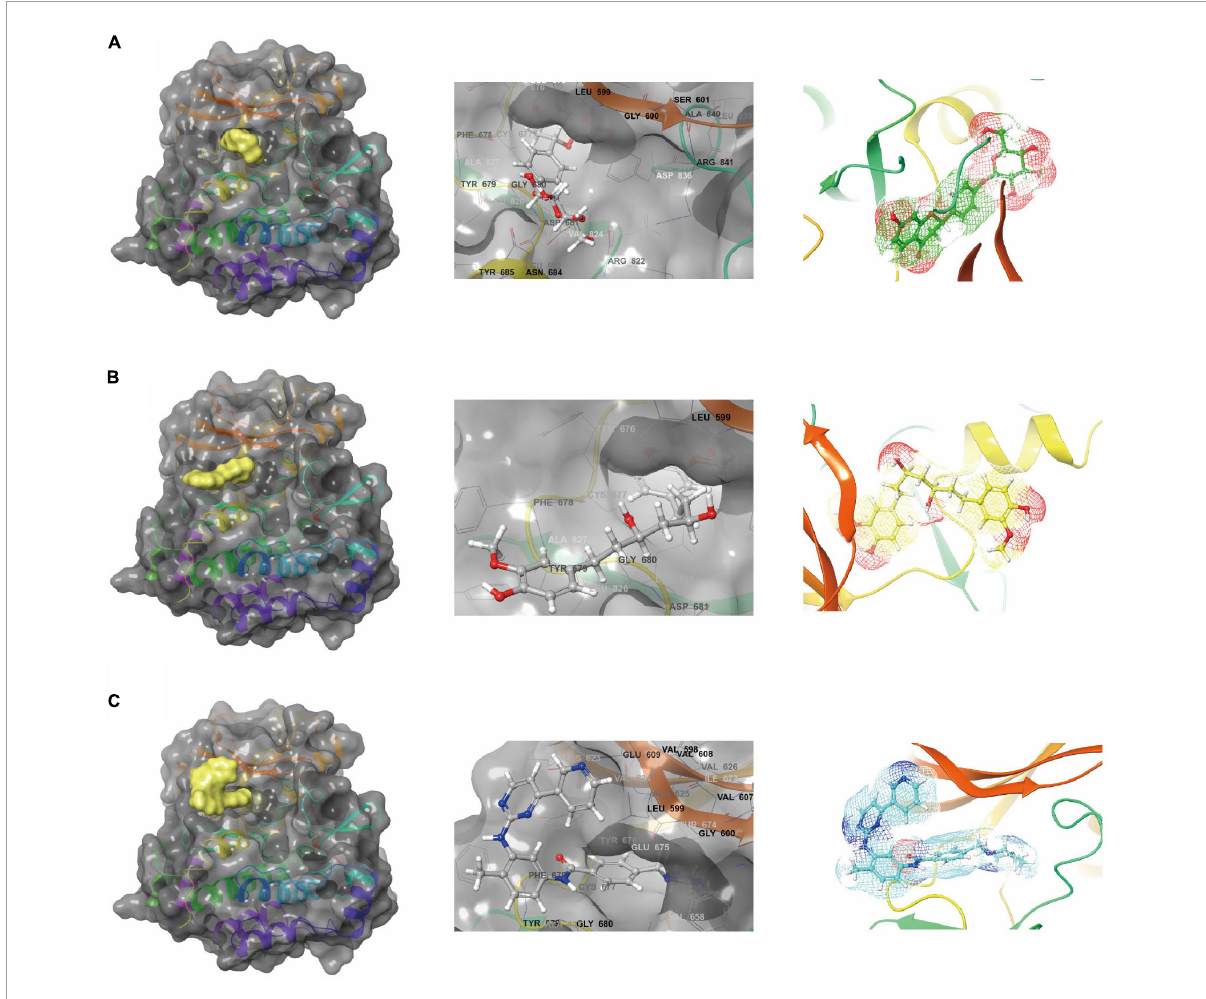
FIGURE3 Schematic drawing of interactions between ligands and platelet-derived growth factor receptor α (PDGFRA) by Schrodinger. (A) ZINC000008829785-PDGFRA complex: structures and net electron cloud structures of ZINC000008829785 are shown in purple sticks. (B) ZINC000013377891-PDGFRA complex: structures and net electron cloud structures of ZINC000013377891 are shown in yellow sticks. (C) Imatinib-PDGFRA complex: structures and net electron cloud structures of Imatinib are shown in green